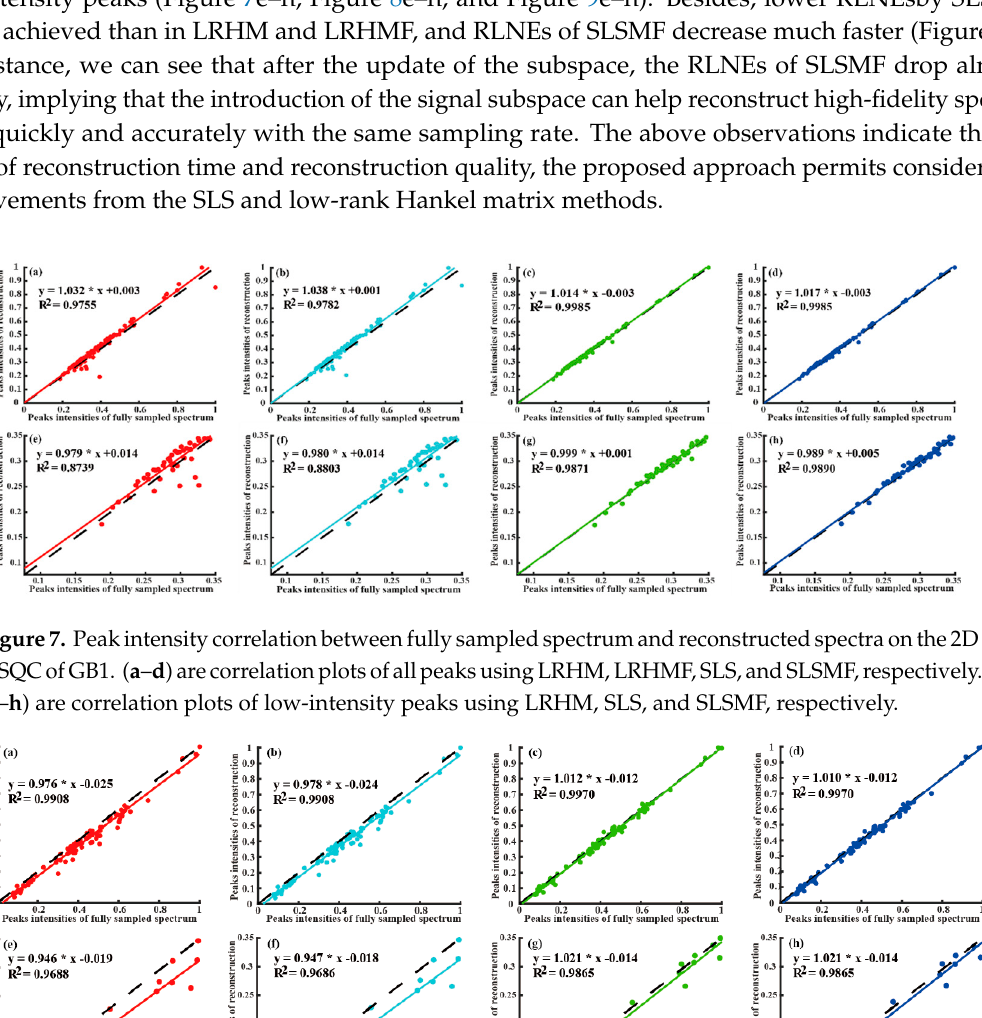
Figure 8. Peak intensity correlation between fully sampled spectrum and reconstructed spectra on the 2D 1 H- 15 N best-TROSY spectrum of ubiquitin. ( a – d ) are correlation plots of all peaks using LRHM, LRHMF, SLS, and SLSMF, respectively. ( e – h ) are correlation plots of low-intensity peaks using LRHM, LRHMF, SLS, and SLSMF, respectively.